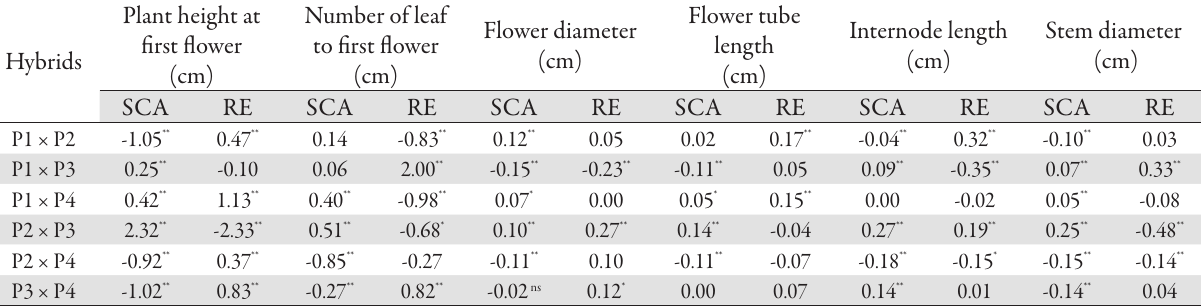
Tab. 4. Estimates of specific combining ability (SCA) and reciprocal (RE) effects of hybrids for plant height at first flower, number of leaf to first flower, flower diameter, flower tube length, internode length and stem diameter in petunia